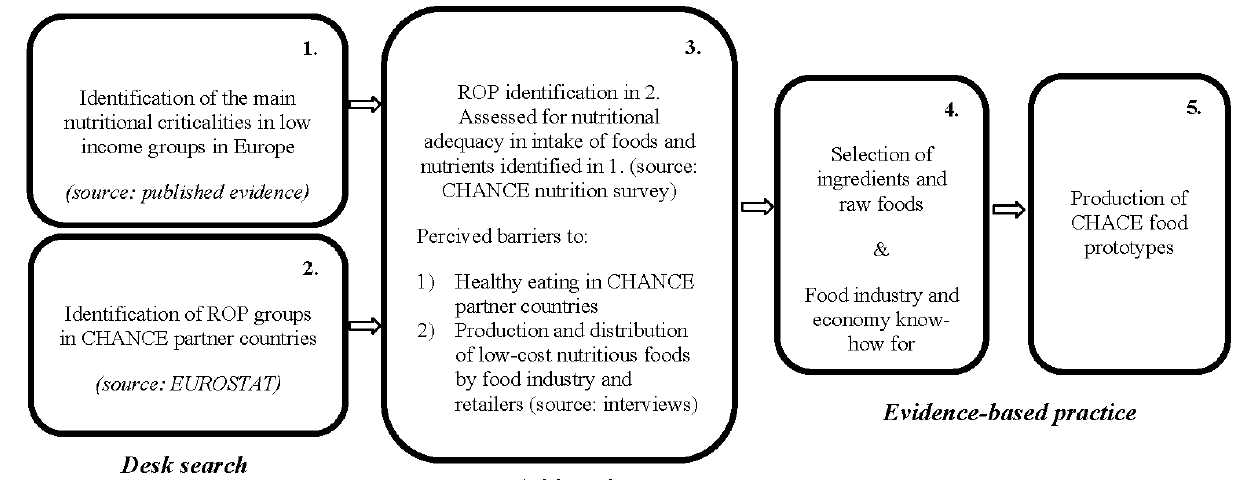
Figure 1. The CHANCE strategy for developing new and affordable nutritionally correct foods and meals in order to improve the diet of population groups at risk of poverty